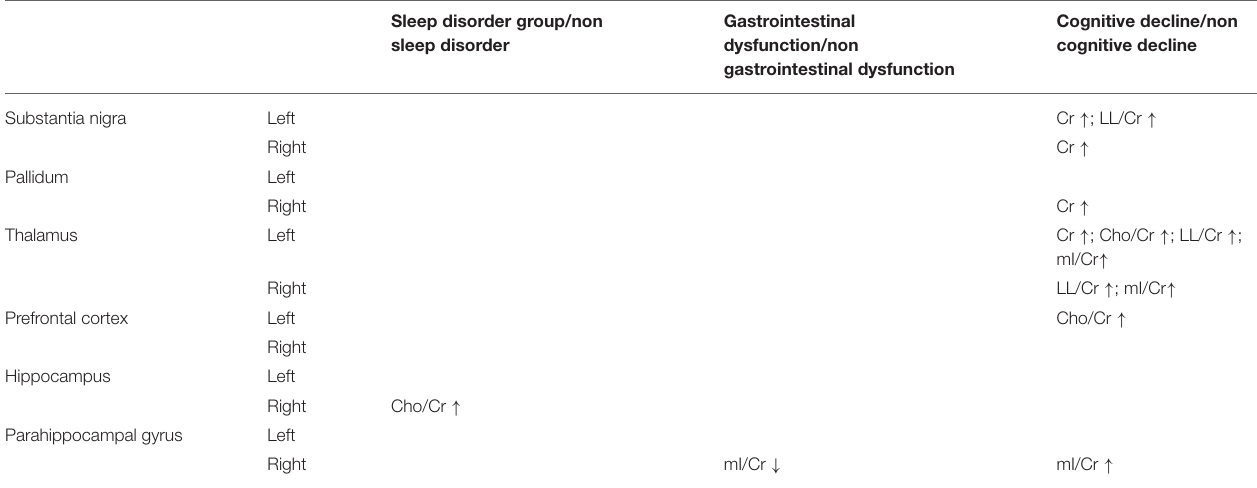
TABLE 4 | The results of MRS in left/right cerebral hemisphere among the three subgroups of NMS-PD.